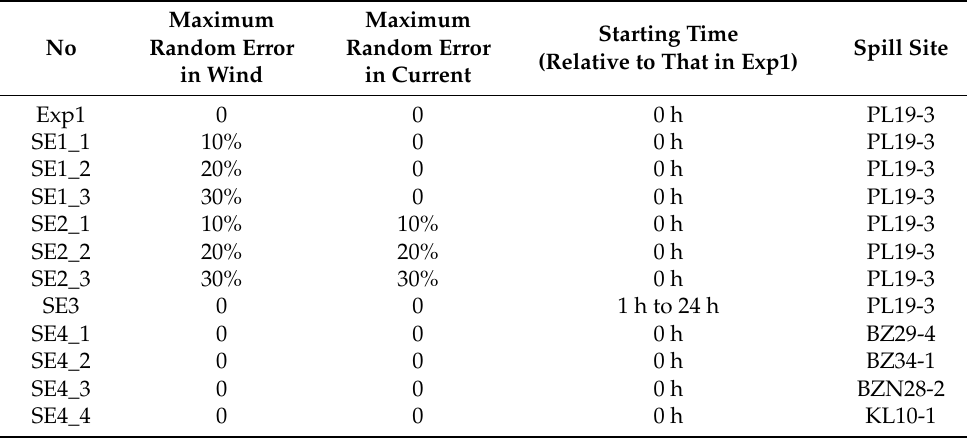
Table 1. Detailed model settings of the numerical